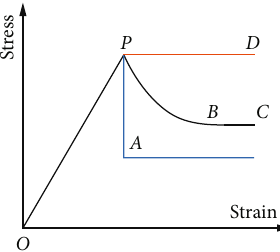
Figure 1: Constitutive model of coal and rock mass